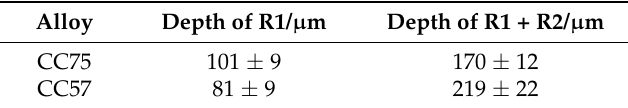
Table 2. Depths of R1 and R2 for CC75 and CC57 on anode side.